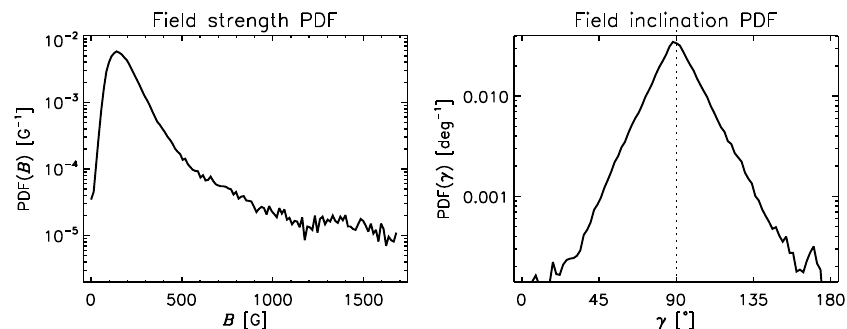
Fig.32 DistributionofmagneticfieldstrengthsandinclinationsderivedfromanMEinversionofHinode/SP data with noise at the level of 3 × 10 − 4 I QS , including only pixels with clear linear polarization signals (Stokes Q or U amplitudes exceeding 4.5 times the noise level). About 90% of those pixels show also Stokes V amplitudes above the same threshold. The distributions represent 27.4% of the field of view. Image reproduced with permission from Orozco Suárez and Bellot Rubio (2012), copyright by